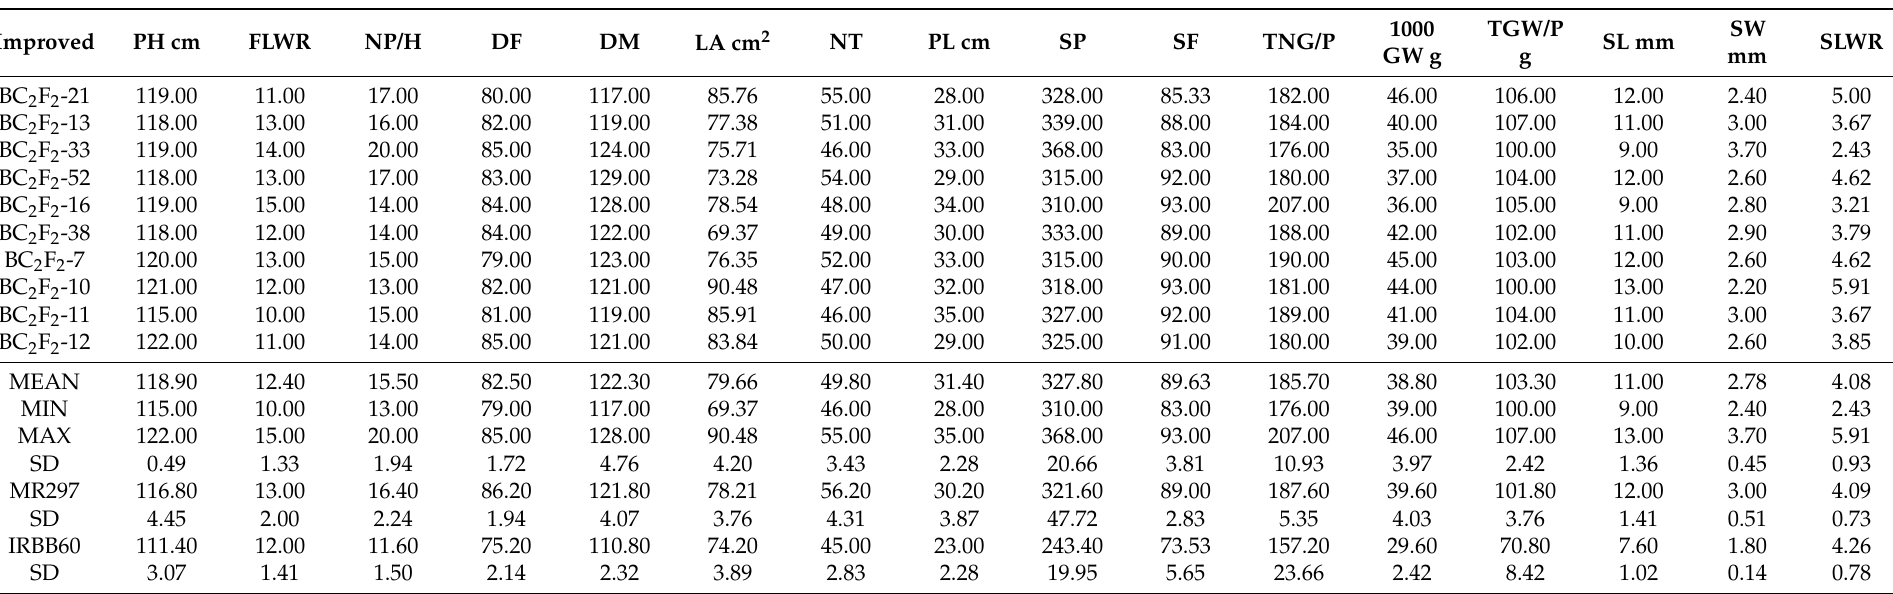
Table 5. The 10 selected BC 2 F 2 lines for agro-morphological